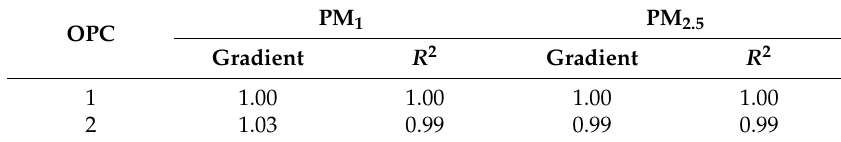
Figure 8. Figures illustrating the reproducibility of the two Alphasense OPC-N2. ( a ) Scatter plot of OPC 1 and OPC 2 PM 1 measurement relative to the period between 17 December 2017 and 16 January 2018; ( b ) OPC 1 and OPC 2 PM 2.5 measurement scatter plot relative to the period between 17 December 2017 and 16 January 2018.